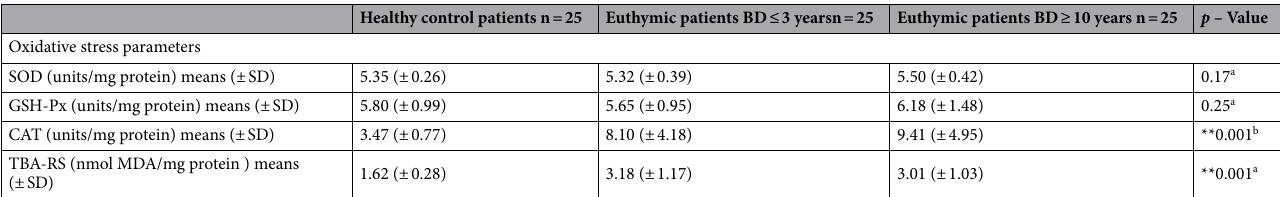
Table 3. Comparison of Oxidative Stress Parameters between the healthy control patients and the Euthymic bipolar patients with ≤ 3 and ≥ 10 years of the disease. Means ± standard deviation (SD). The normality of each variable was analyzed using the Kolmogorov–Smirnov normality test. a To compare parametric variables between the three independent groups, two-way analysis of variance (ANOVA) followed by Tukey’s test was used. b To compare nonparametric variables between the three independent samples, the Kruskal–Wallis test was used. Dunn’s post hoc test was performed for pairwise comparisons if the main effects were significant. Statistical significance was set at ** p < 0.001 for all tests.